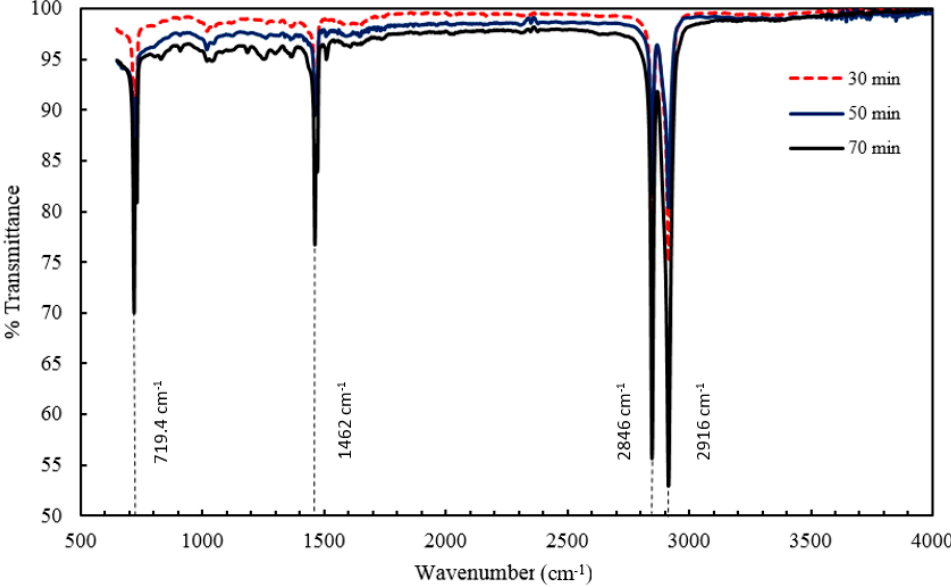
Figure 5. Fourier transform infrared (FTIR) spectra of injection molded HDPE/TiO 2 nanocomposites at 5 wt % TiO 2 and a barrel temperature of 250 °C. Residence time was varied at 30 min, 50 min, and 70 min.